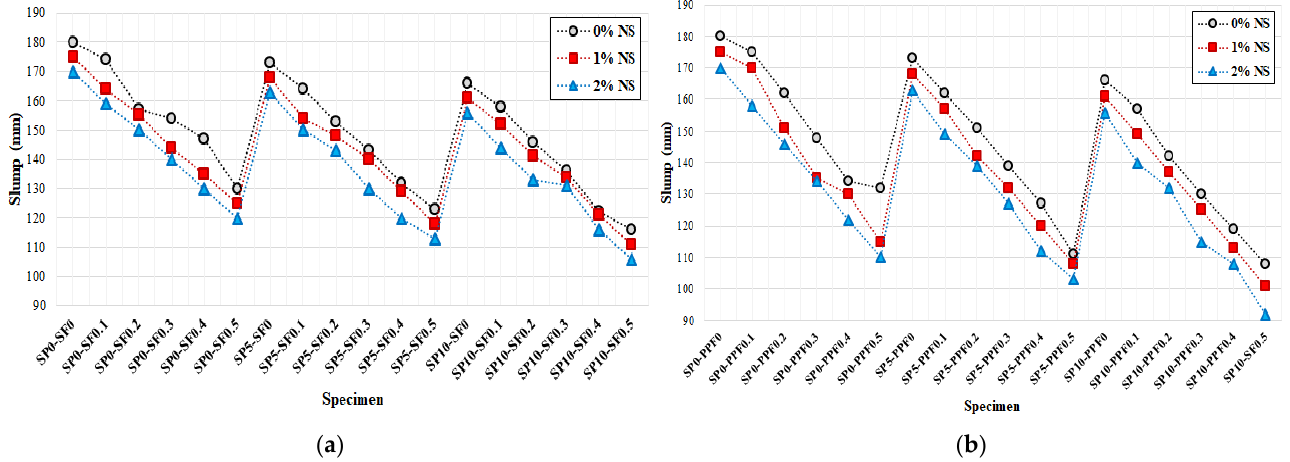
Figure 7. Influence of SP on the slump of HSC containing various NS and fibres ( a ) SF and ( b ) PPF.